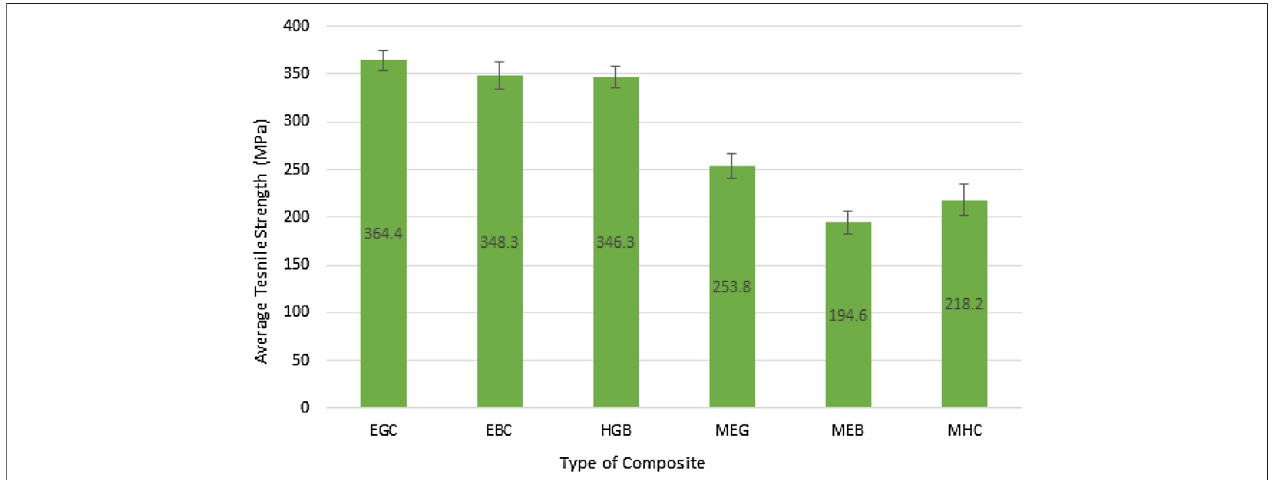
FIGURE 2 | Tensile strength of different